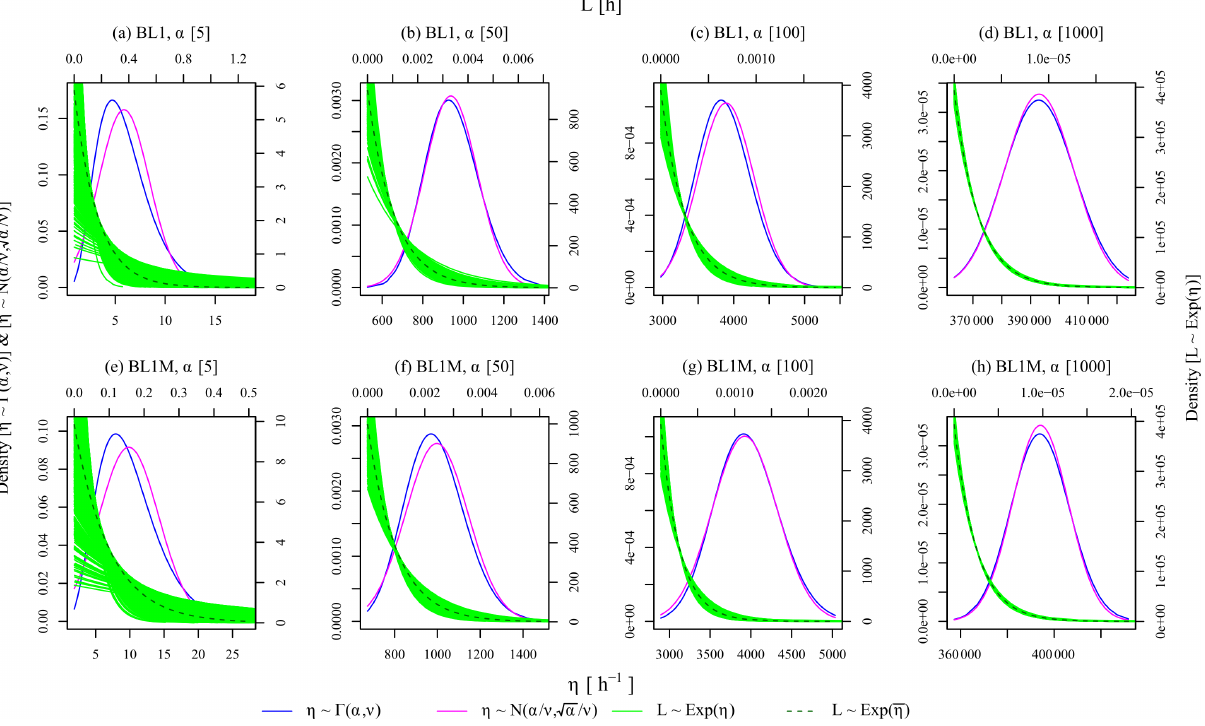
Figure A2. Fitted gamma distributions for the cell duration parameter η for the BL1 and BL1M models with α = 5, 50, 100, and 1000. Plots show the equivalent normal distributions fitted to the mean and SD of the gamma distributions. The range of exponential distributions for the cell duration parameter η is obtained by sampling 500 η values from the fitted gamma distributions. The exponential distributions for the mean of the fitted gamma distributions are also shown.